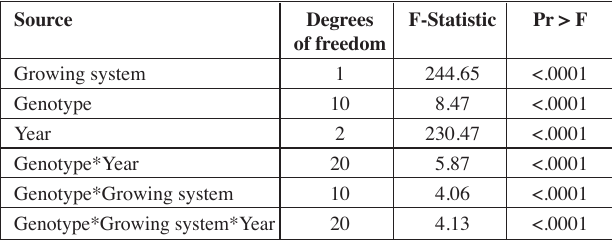
Tab. 3: Results of the ANOVA for